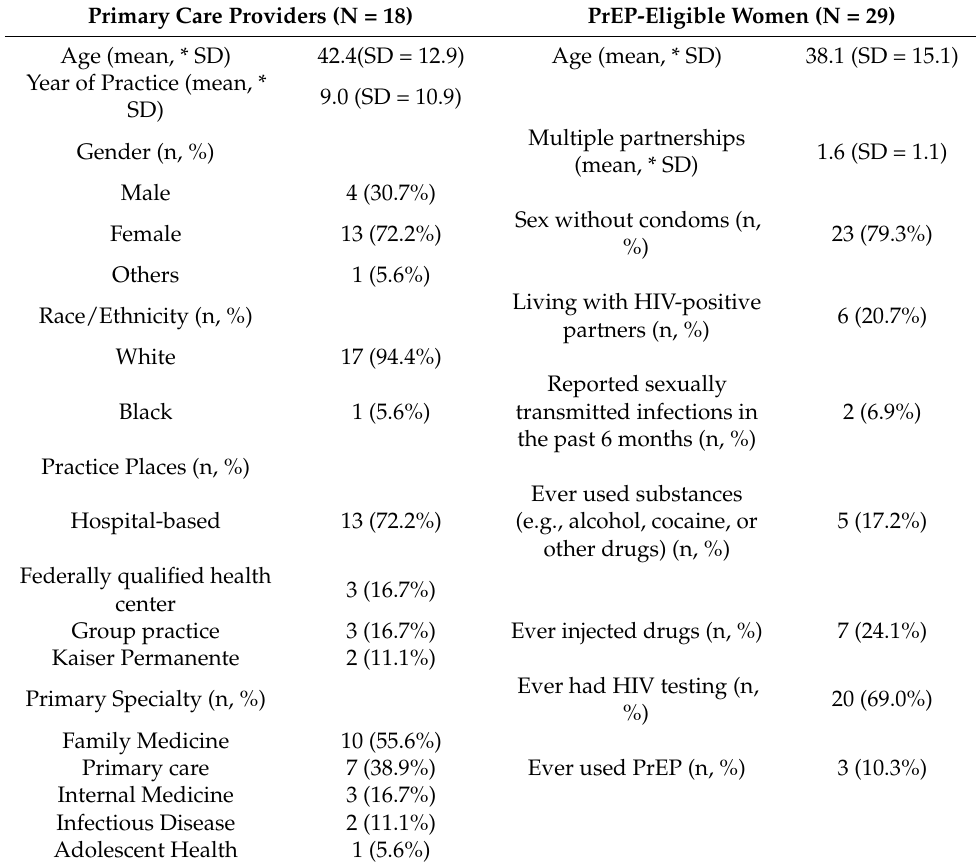
Table 1. Demographics and Key Characteristics of Included